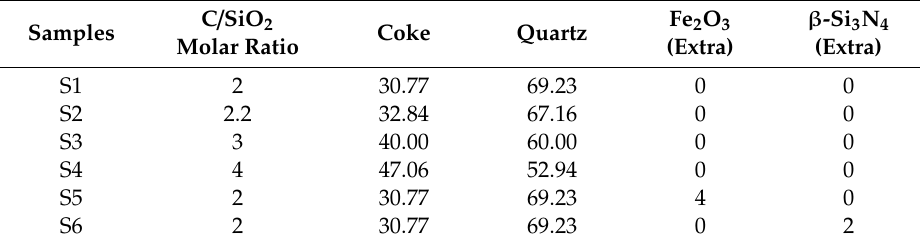
Table 1. Compositional design of the samples